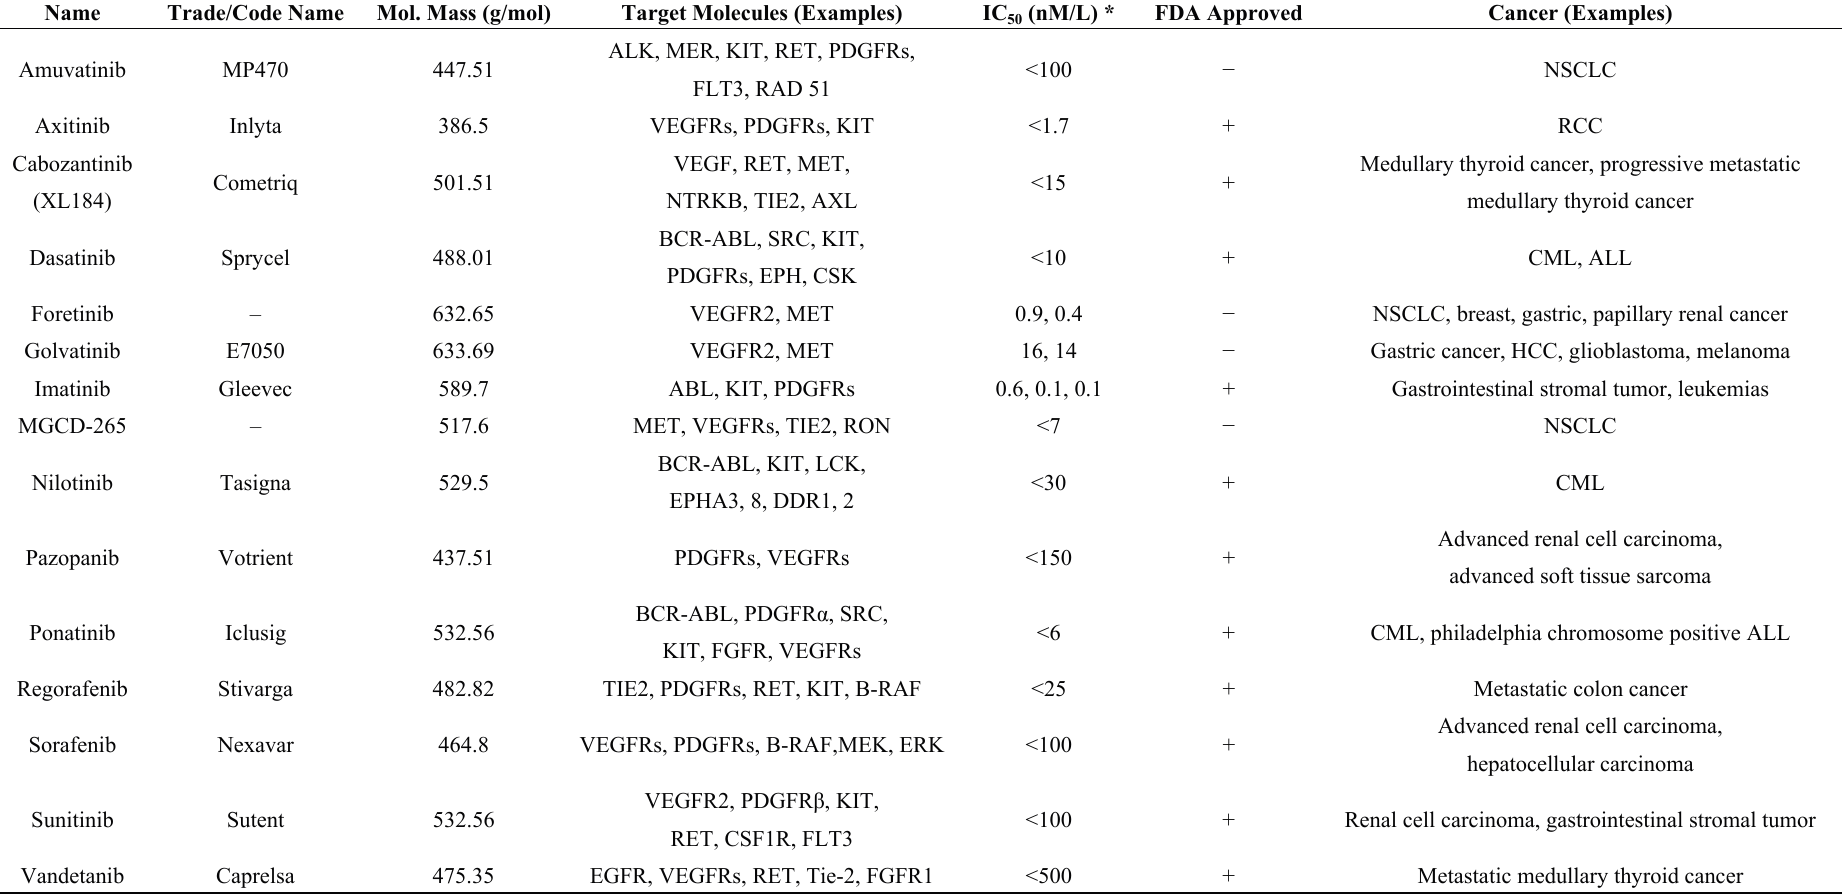
Table 3. Multi-targeted tyrosine kinase inhibitors (TKIs) targeting RTKs and intracellular